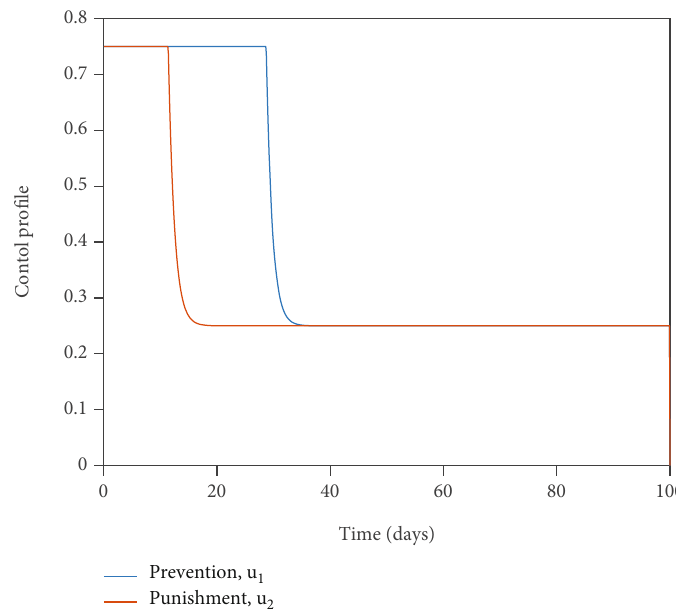
Figure 5: Simulation showing the pro fi le for the optimal control u